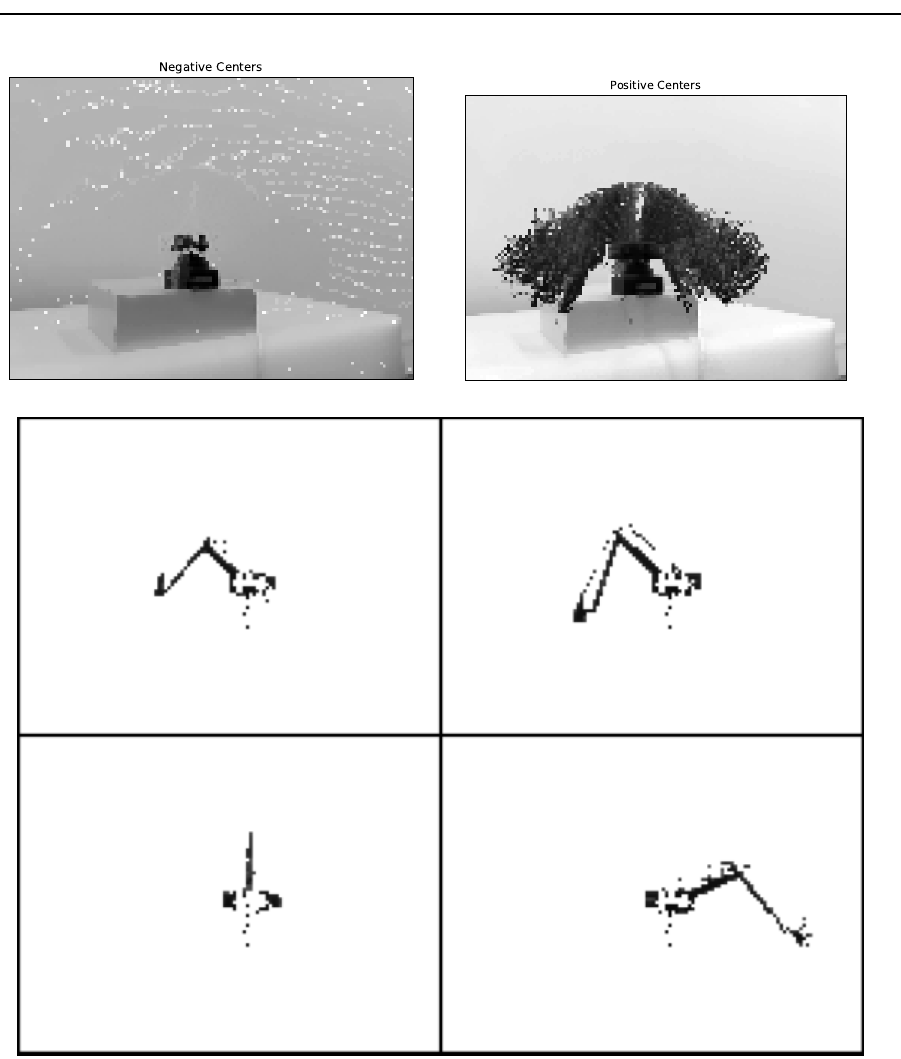
Figure 3. Learning background subtractor. The images at the top are positive (motion) and negative (background) centres and below are exemplary frames after background